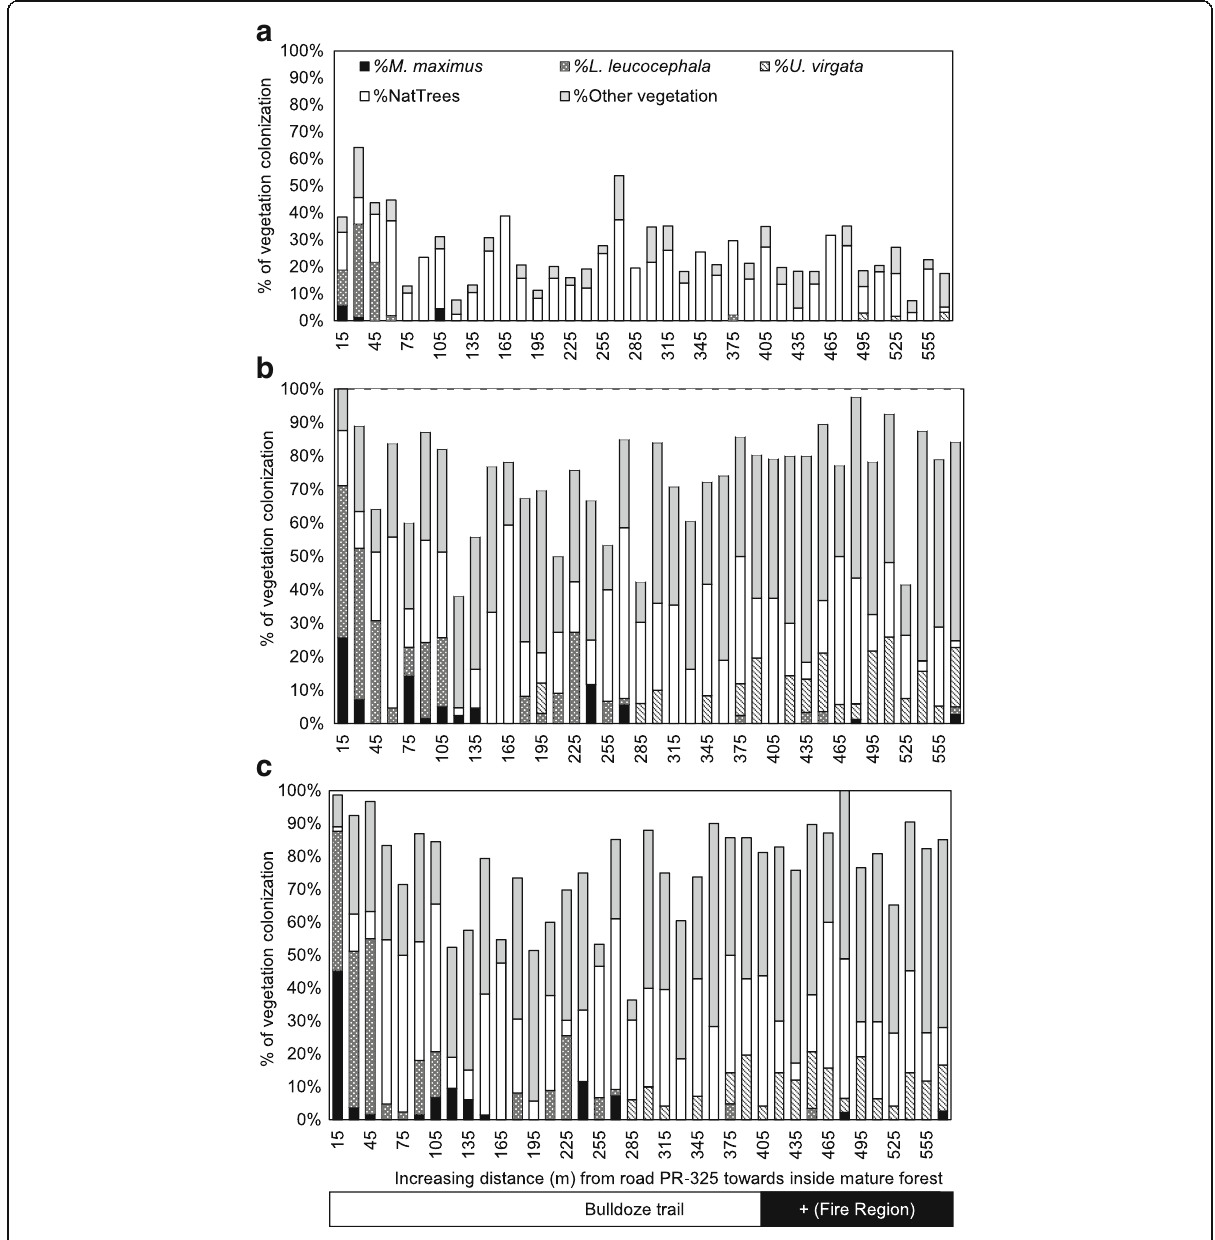
Fig. 2 Post-bulldozing colonization patterns recorded during a July 2012, b December 2012, and c July 2013. Note: Locations where none of the three species under study occurred were dominated by sprouting native trees, other vegetation (i.e., any vegetation other than the focal species or native trees), or barren land (the difference between the bar and